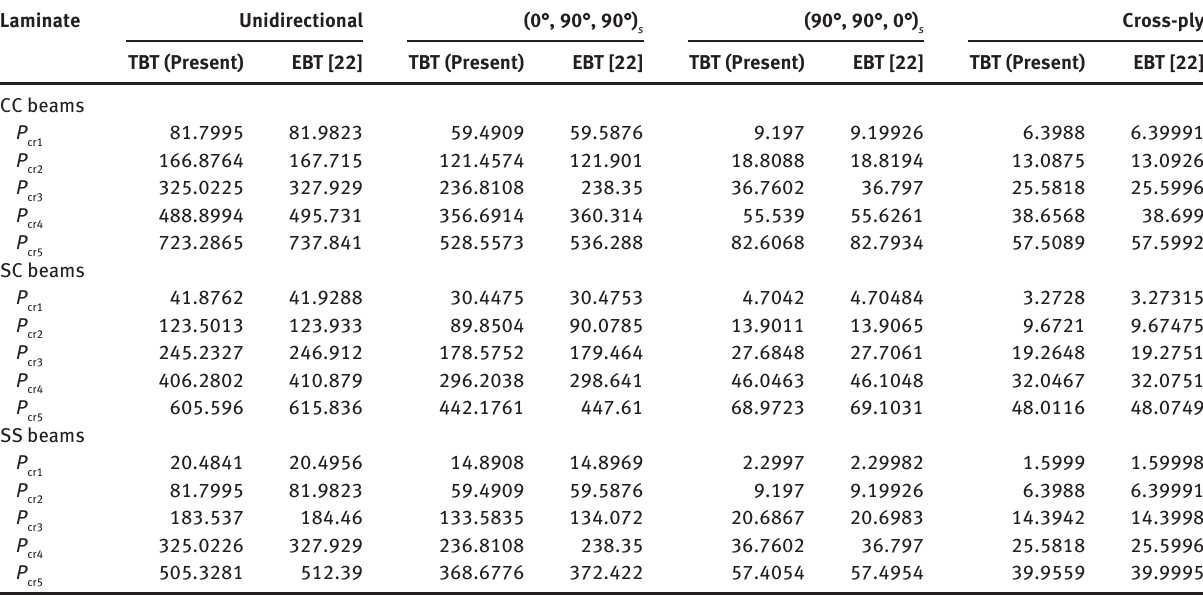
Table 1 First five critical buckling loads (N) for different laminates of CC, SC, and SS beams ( L/h = 250).